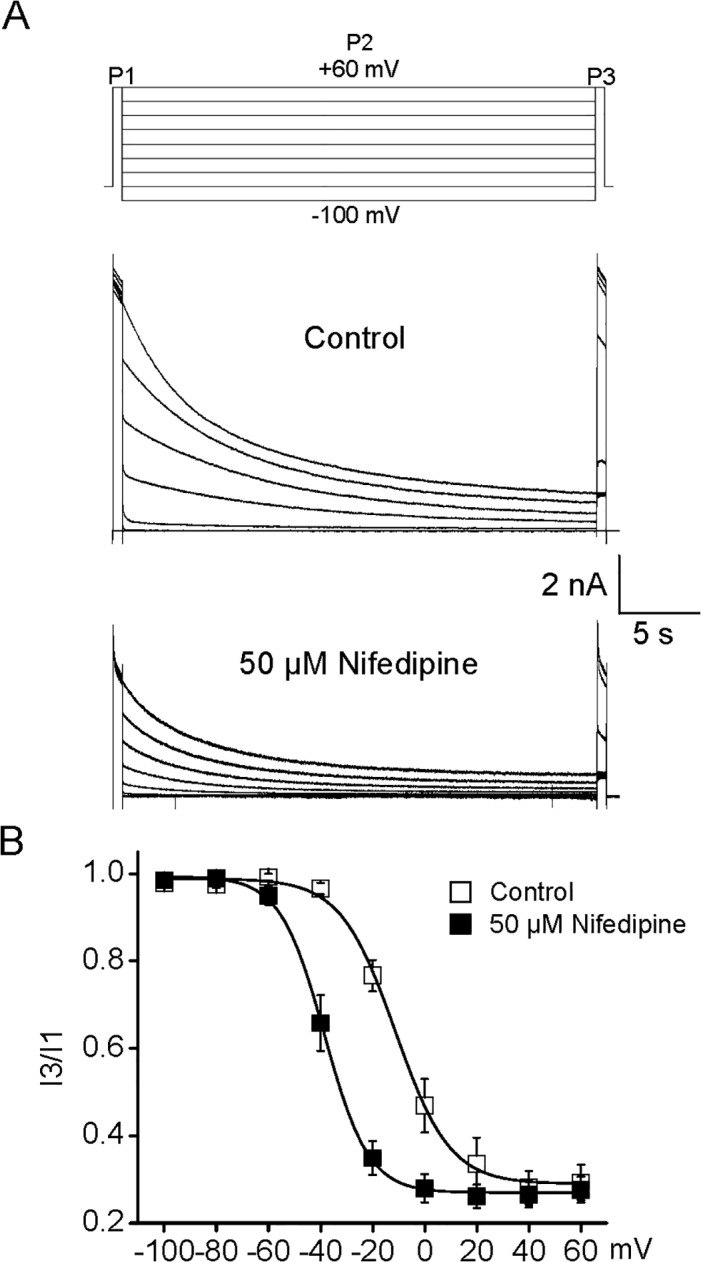
Nifedipine induced a large left shift of the inactivation curve of Kv2.1 currents.(A) The schematic illustrated the three-pulse protocol employed to elicit the currents for building the inactivation curve (top panel). Representative Kv2.1 currents generated by three-pulse protocol in the absence (middle panel) and presence (bottom panel) of nifedipine were shown. (B) The inactivation curves of Kv2.1 currents in the absence and presence of 50 μM nifedipine were constructed by plotting the ration of currents (I3/I1) against the P2 voltage. The steady-state inactivation data were well described by a single Boltzmann with V
1/2 of—11.4 mV and k of 8.5 mV in control, as well as V
1/2 of—38.5 mV and k of 10.1 mV in the presence of 50 μM nifedipine (n = 8).